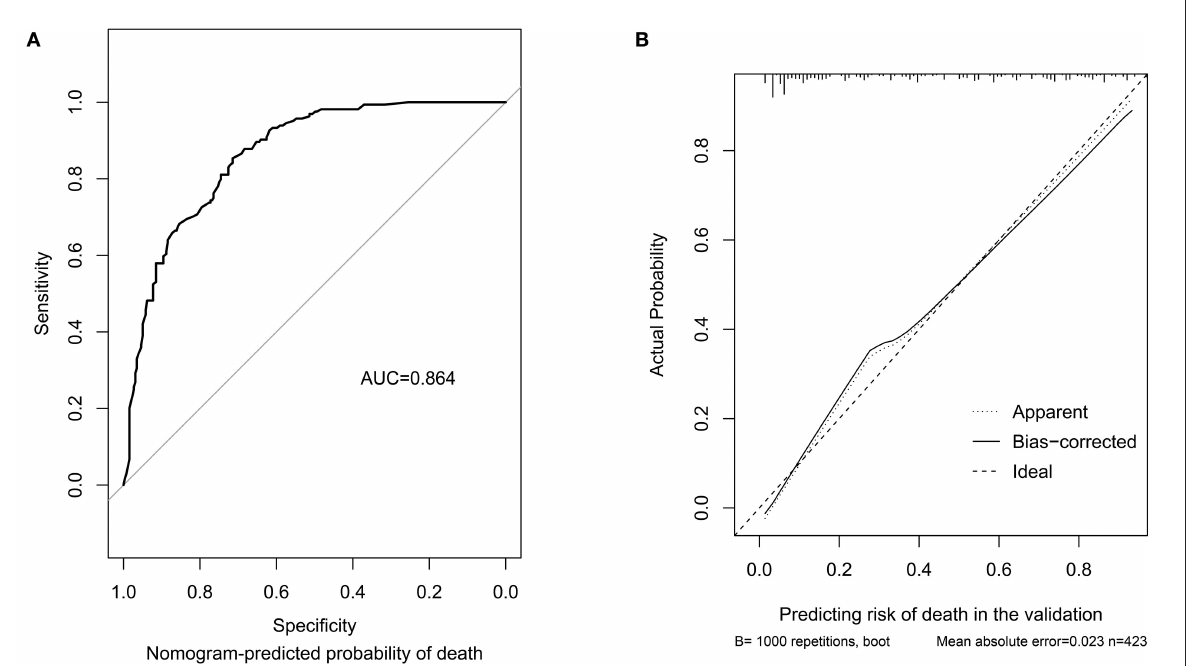
FIGURE2 Discrimination performance and predictive consistency of the tool for predicting death risk in internal validation. (A) ROC curve and AUC of the tool for predicting probability of death; (B) calibration curves of the tool predicting probability of death. The dotted line represents a perfect prediction by an ideal model, and the solid line represents the performance of the nomogram in the validation. A closer fit of the lines represents a better prediction. ROC, receiver operating characteristic; AUC, area under curve; ICU, intensive care